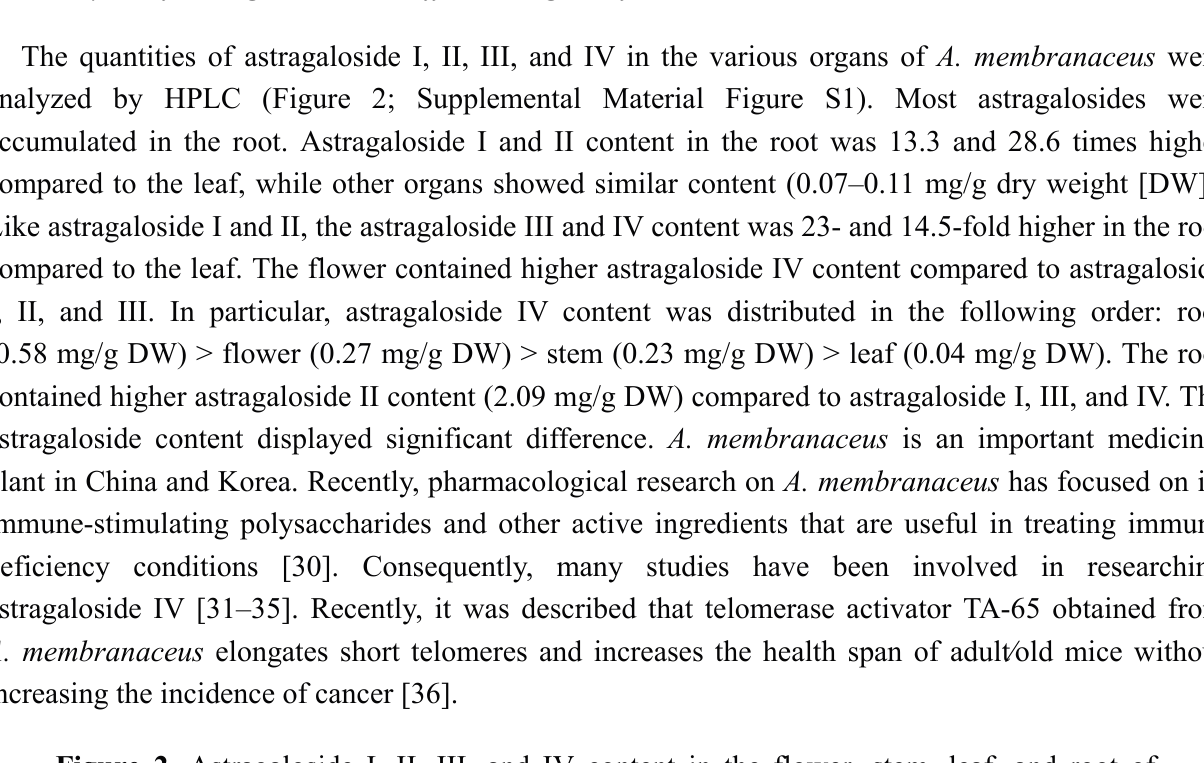
Figure 2. Astragaloside I, II, III, and IV content in the flower, stem, leaf, and root of Huangqi. The height of each bar and the error bars show the mean and standard error, respectively, based on 3 independent